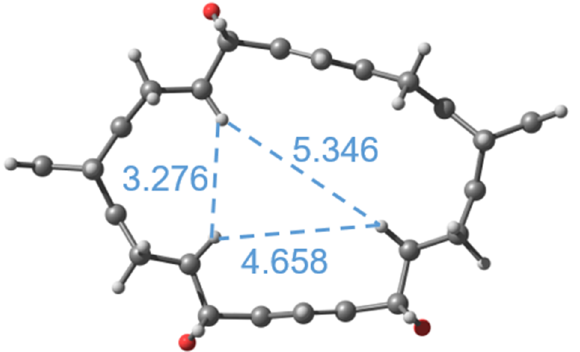
Figure 3. Molecular structure of macrocycle 12 as computed at the M062X/6-311+G**/toluene level of theory. Distances between endo -H atoms are given in Å (blue): Red, oxygen; dark gray, carbon; light gray, hydrogen.